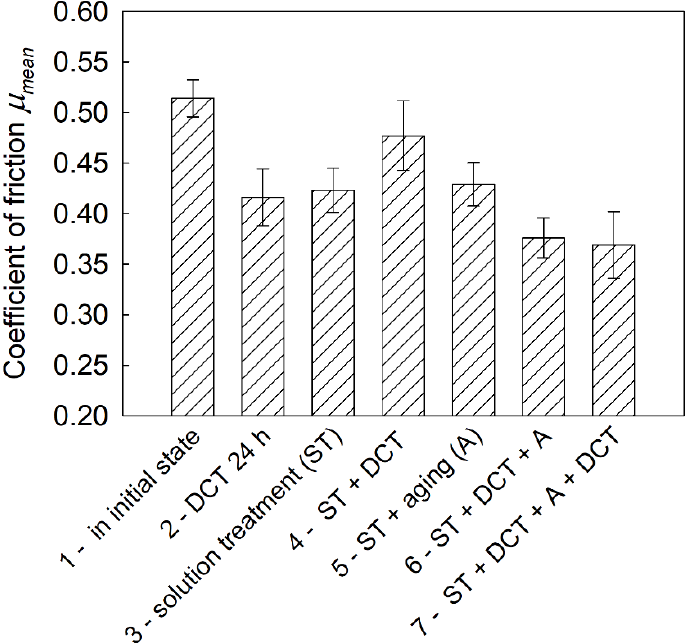
Figure 13. Stabilized friction coefficient of the Mg-Y-Nd alloy in the initial state and after different heat treatment variants in combination with DCT.